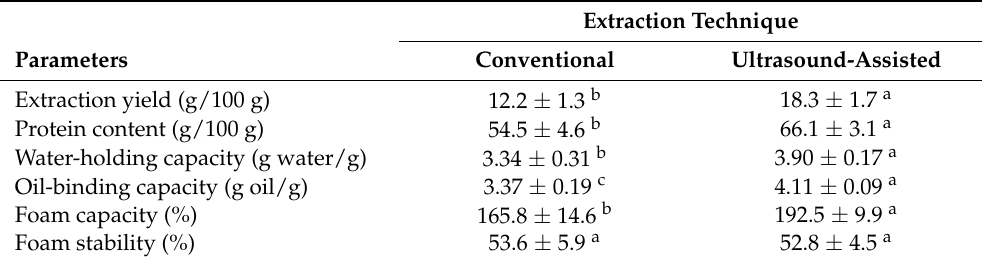
Table 3. Physicochemical and functional properties of cherimoya-seed-protein concentrate obtained by different extraction